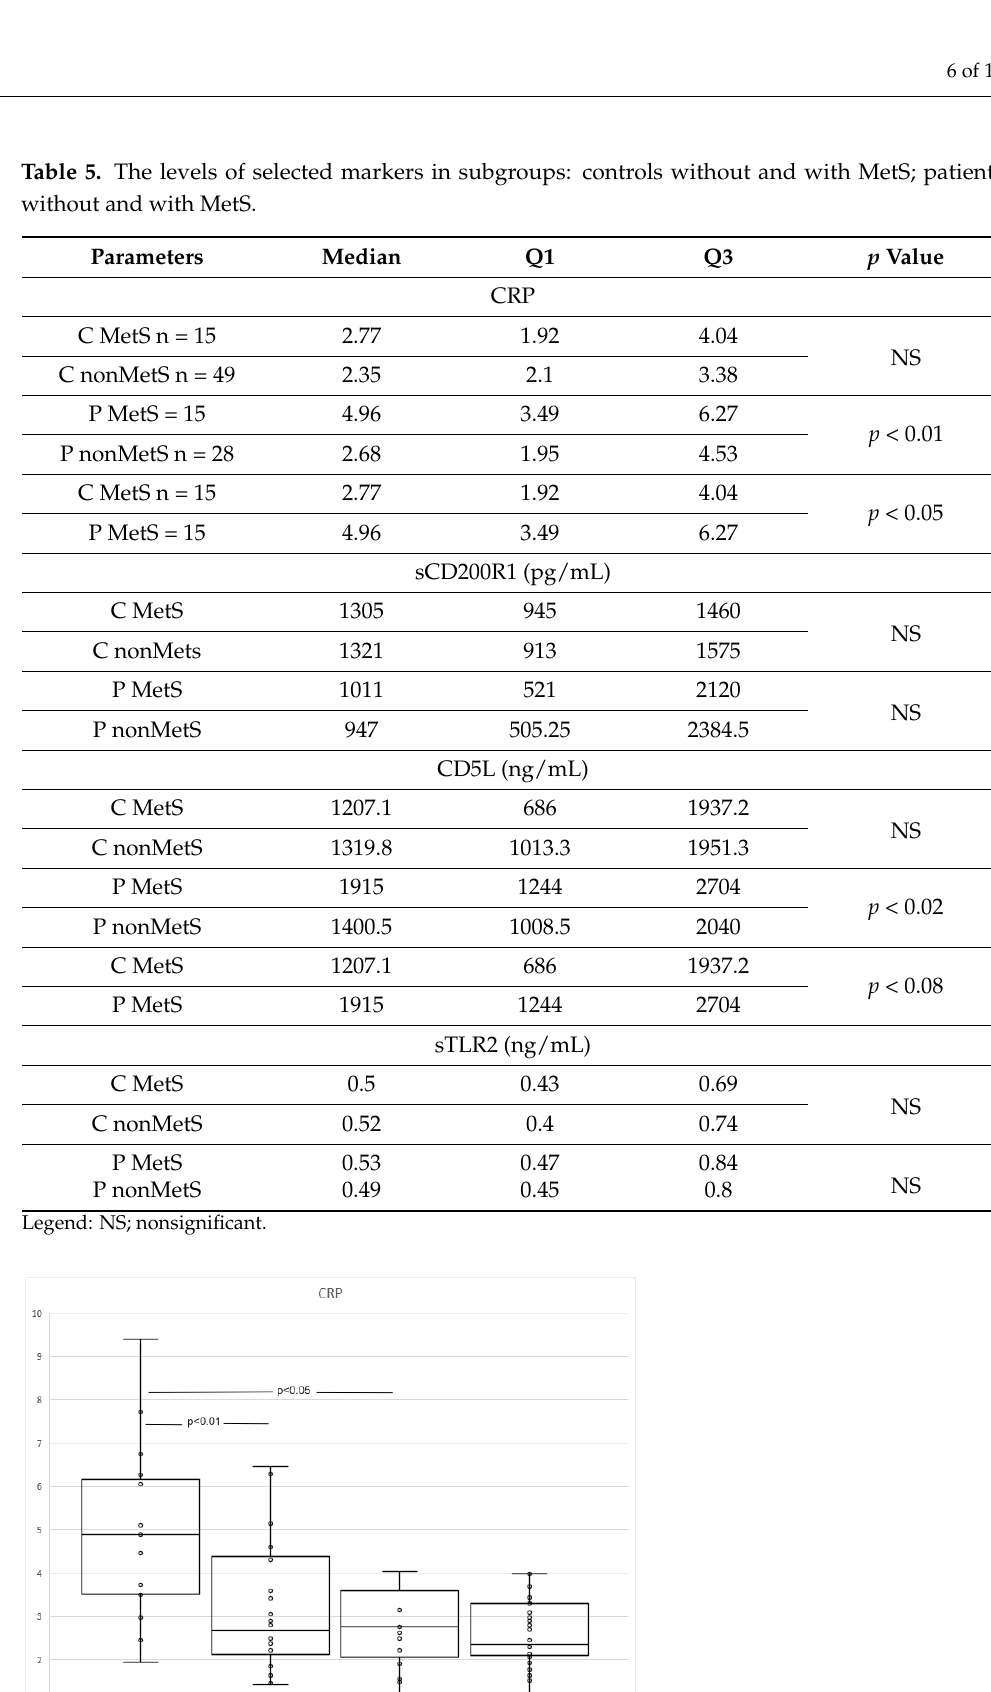
Figure 1. The levels of CRP in MetS and nonMets patients and controls. Within each box, the middle line of the box represents the median. Boxes extend from the 25th–75th percentile of each group’s distribution of values. Whiskers above and below the box indicate the 10th and 90th percentiles.